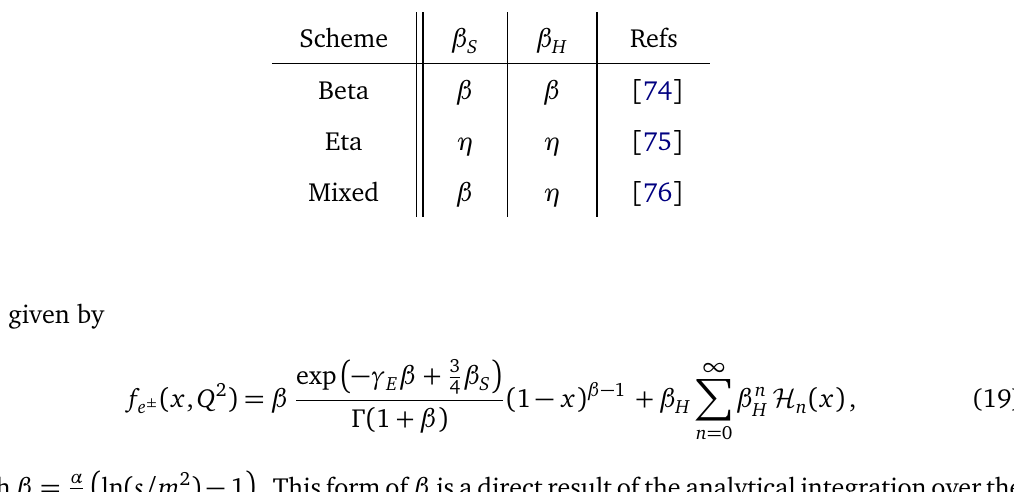
Table 5: The different scheme choices available in S HERPA for the electron